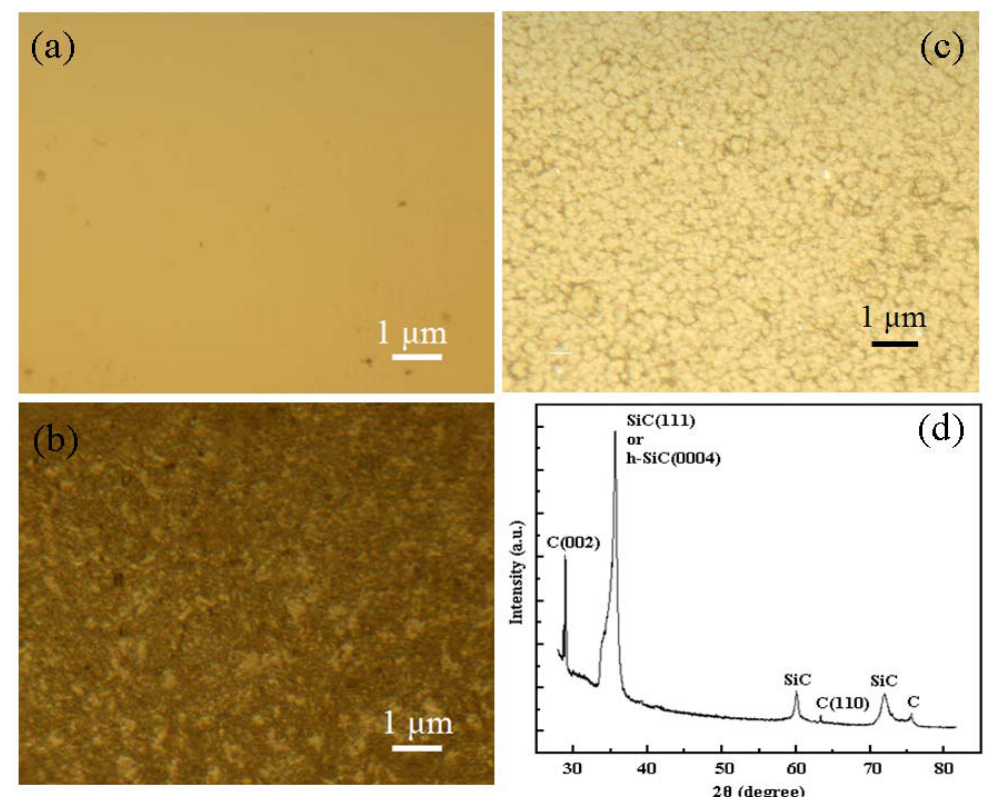
Figure 2. Morphologies of: ( a ) as-received substrate surface; ( b ) GGNs covered surface; ( c ) SiC film surface; and ( d ) XRD patterns of the thin film after SiC